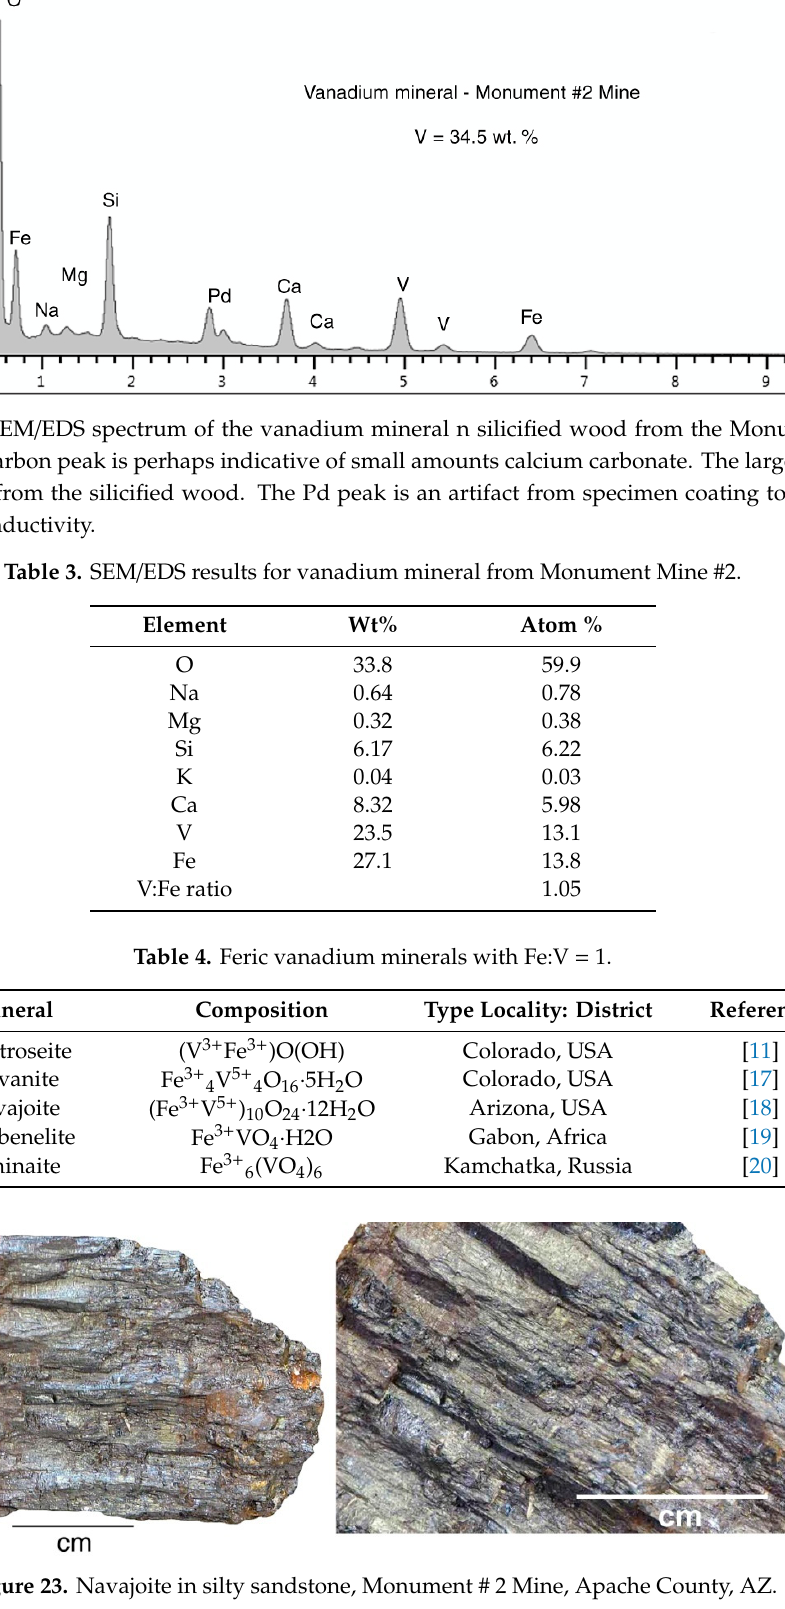
Figure 23. Navajoite in silty sandstone, Monument # 2 Mine, Apache County, AZ.